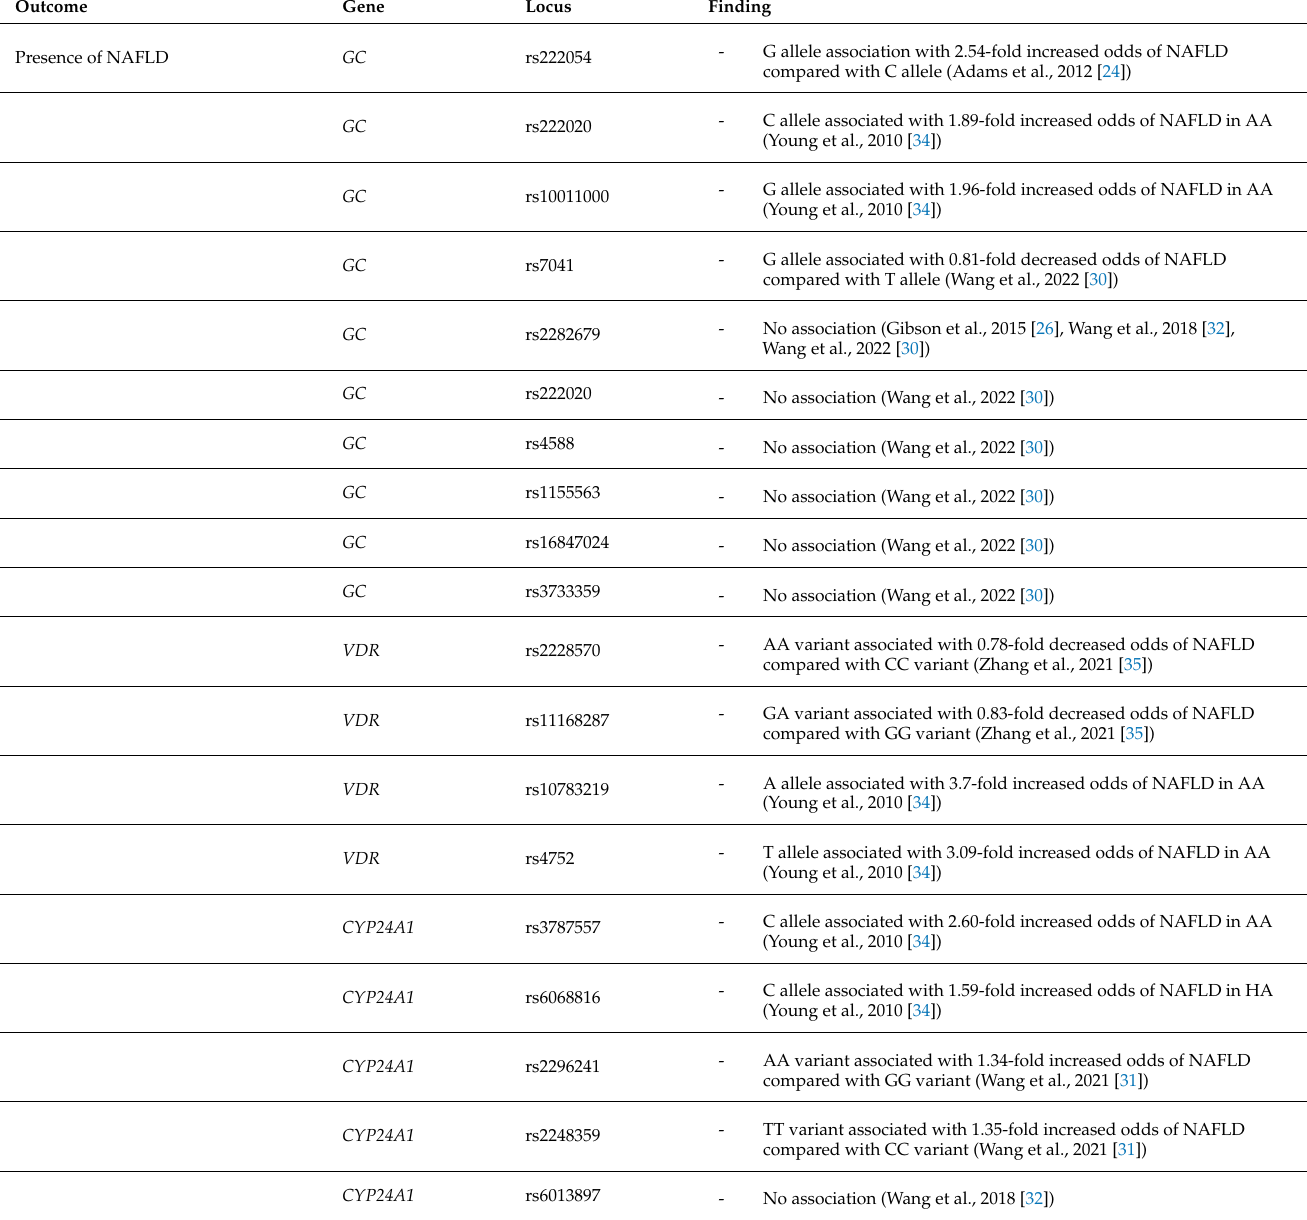
Table 2. Association between vitamin D-related genetic variations and presence, severity and re- sponse to treatment of